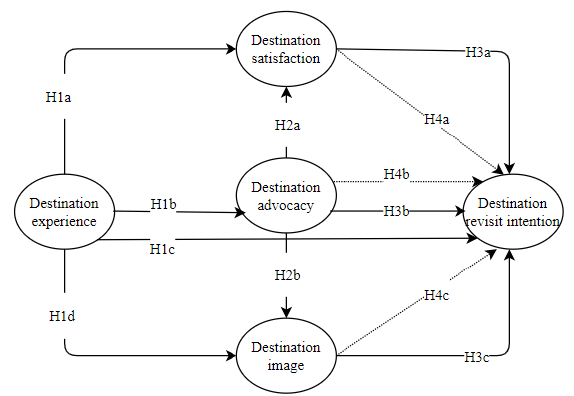
Figure 1. Authors conceptual research